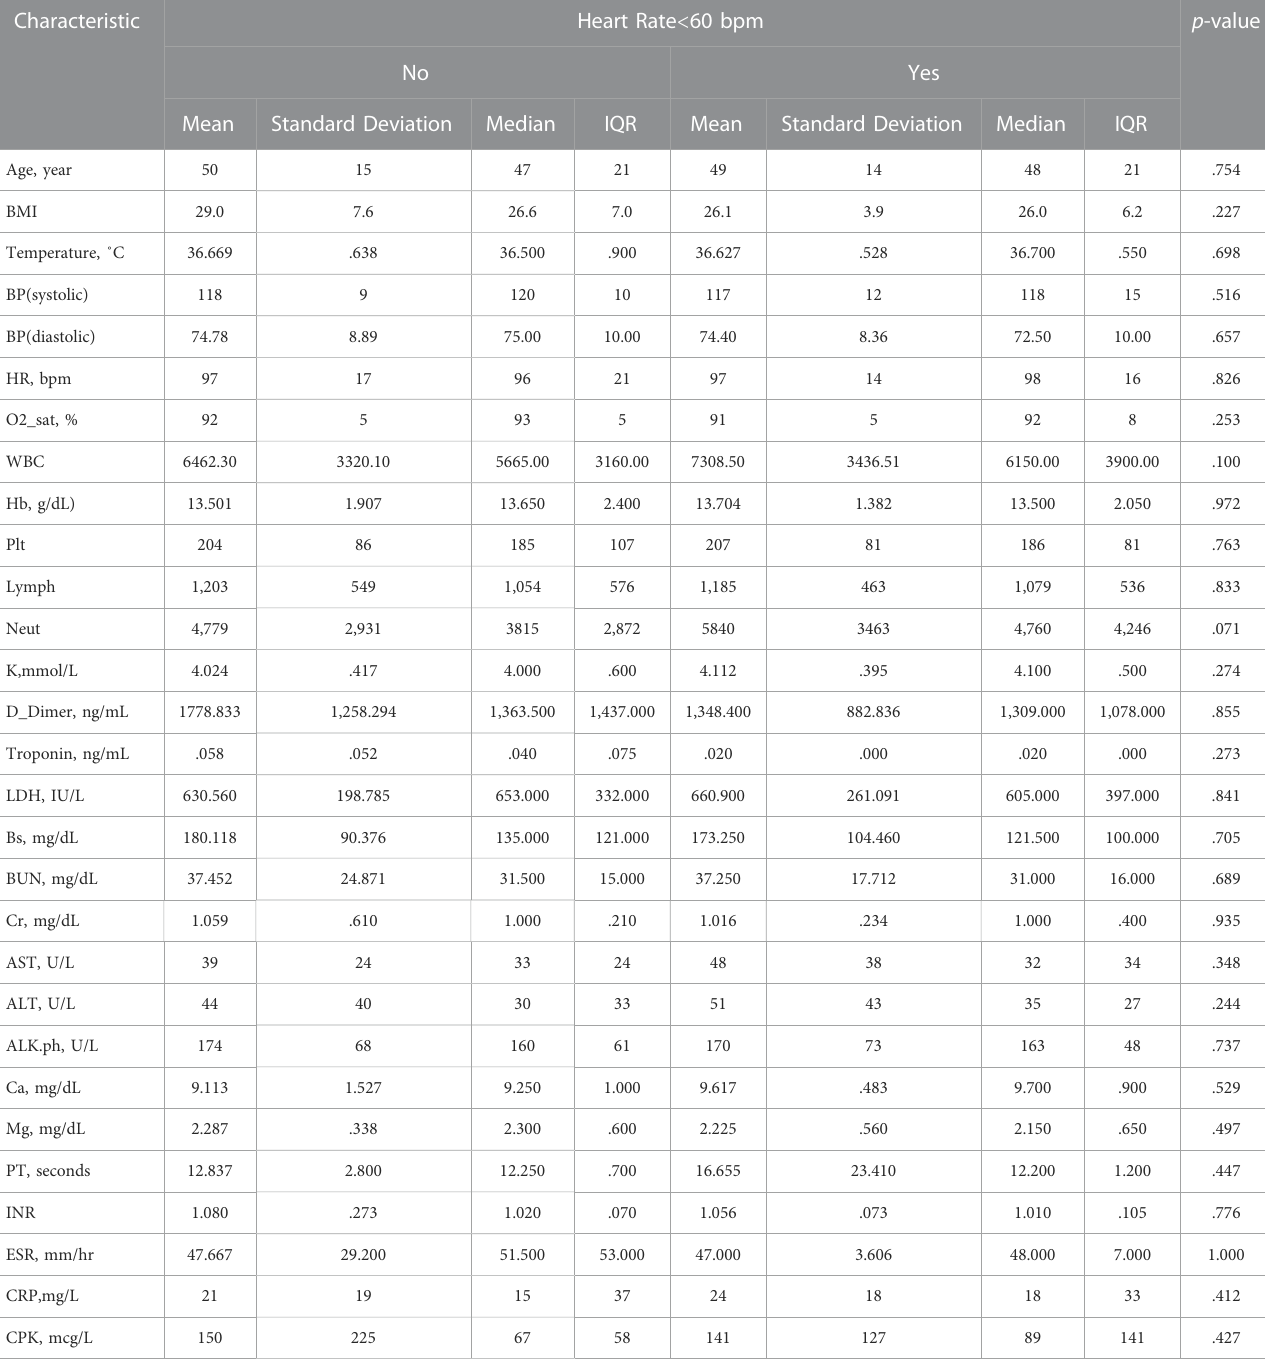
TABLE 1 Comparing medians of quantitative variables between two groups of patients (heart rate < 60 and heart rate ≥ 60) using Mann-Whitney U test.